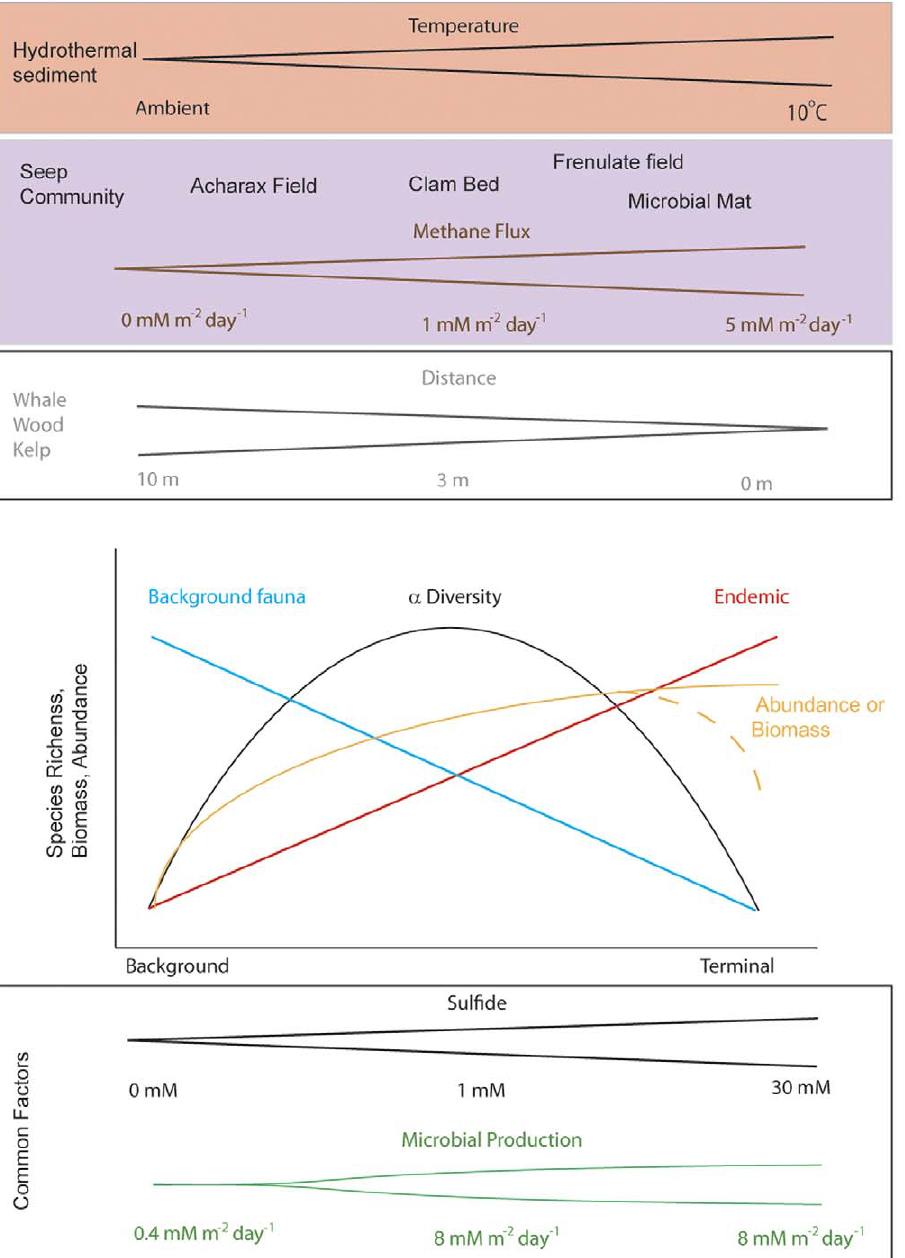
Figure 6. A conceptual framework of factors shaping the biodiversity, density, and biomass of macrofauna in reducing ecosystems. The top three panels highlight drivers that are unique to certain systems. The bottom two panels provide axes for features that are similar among systems (note that while values are given for these two axes the values are not consistent across the different ecosystems represented although the relative scale is). The middle panel illustrates how these factors translate into community attributes of each of the ecosystems. The bifurcation in the abundance and biomass factors indicate that, depending on the system, stress overrides high productivity in these habitats and both biomass and species richness fall bellow an intermediate level (e.g. hydrothermal sediments where the temperature stress overrides the importance of a high productivity system).